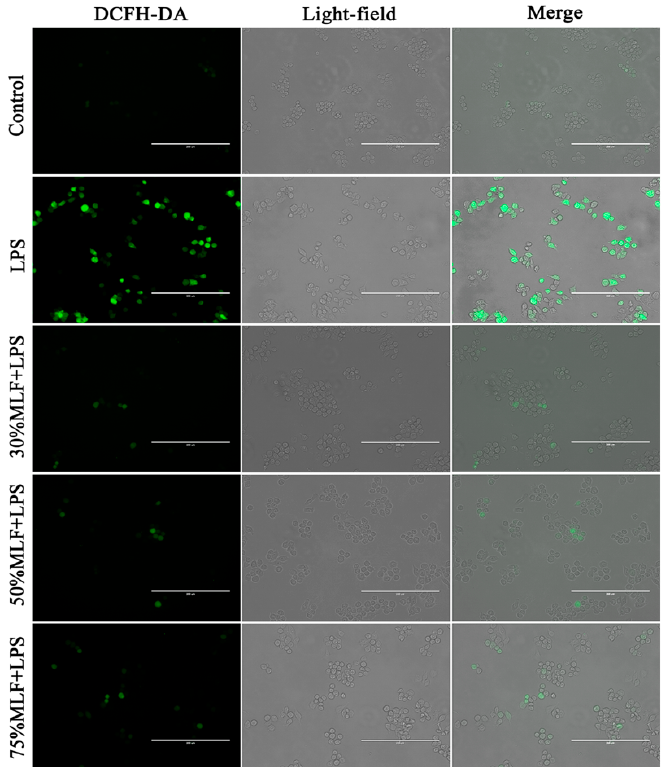
Figure 4. Effects of MLFs on ROS production in LPS-induced RAW 264.7 cells. DCFH-DA was used as a fluorescent probe to stain intracellular ROS, and fluorescence microscopy images show the intracellular generation of ROS. Scale bars, 200 μ m.